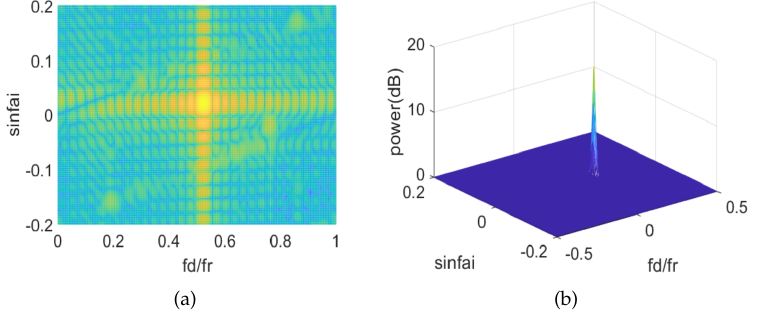
Figure 12. STAP results of proposed method: ( a ) two-dimensional frequency response plane diagram, ( b ) the output result after